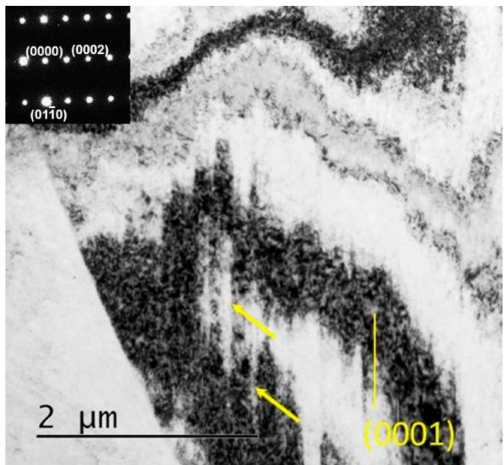
Figure 5. Transmission electron microscope image of sample